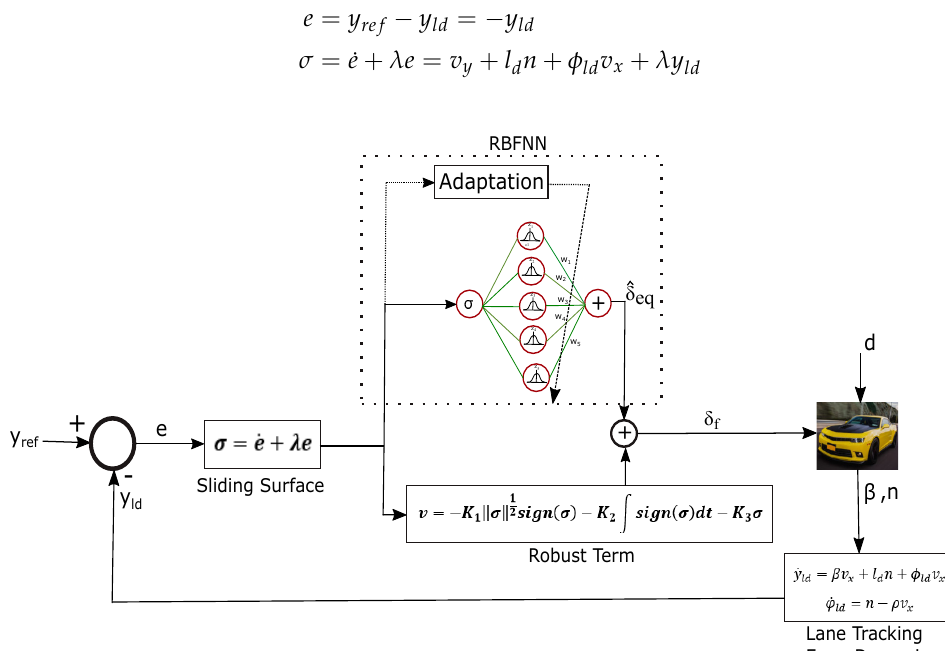
Figure 2. Overall schematic of the closed-loop radial basis function neural network (RBFNN) based higher order sliding mode controller (HOSMC) for the lateral control of the vehicle. y ld : lateral offset at look ahead distance l d , φ ld : heading error at look ahead distance l d , n : yaw-rate, β : side-slip angle, δ f : road steer angle, d : unknown disturbances acting on the front wheel angle, y lr : reference projected